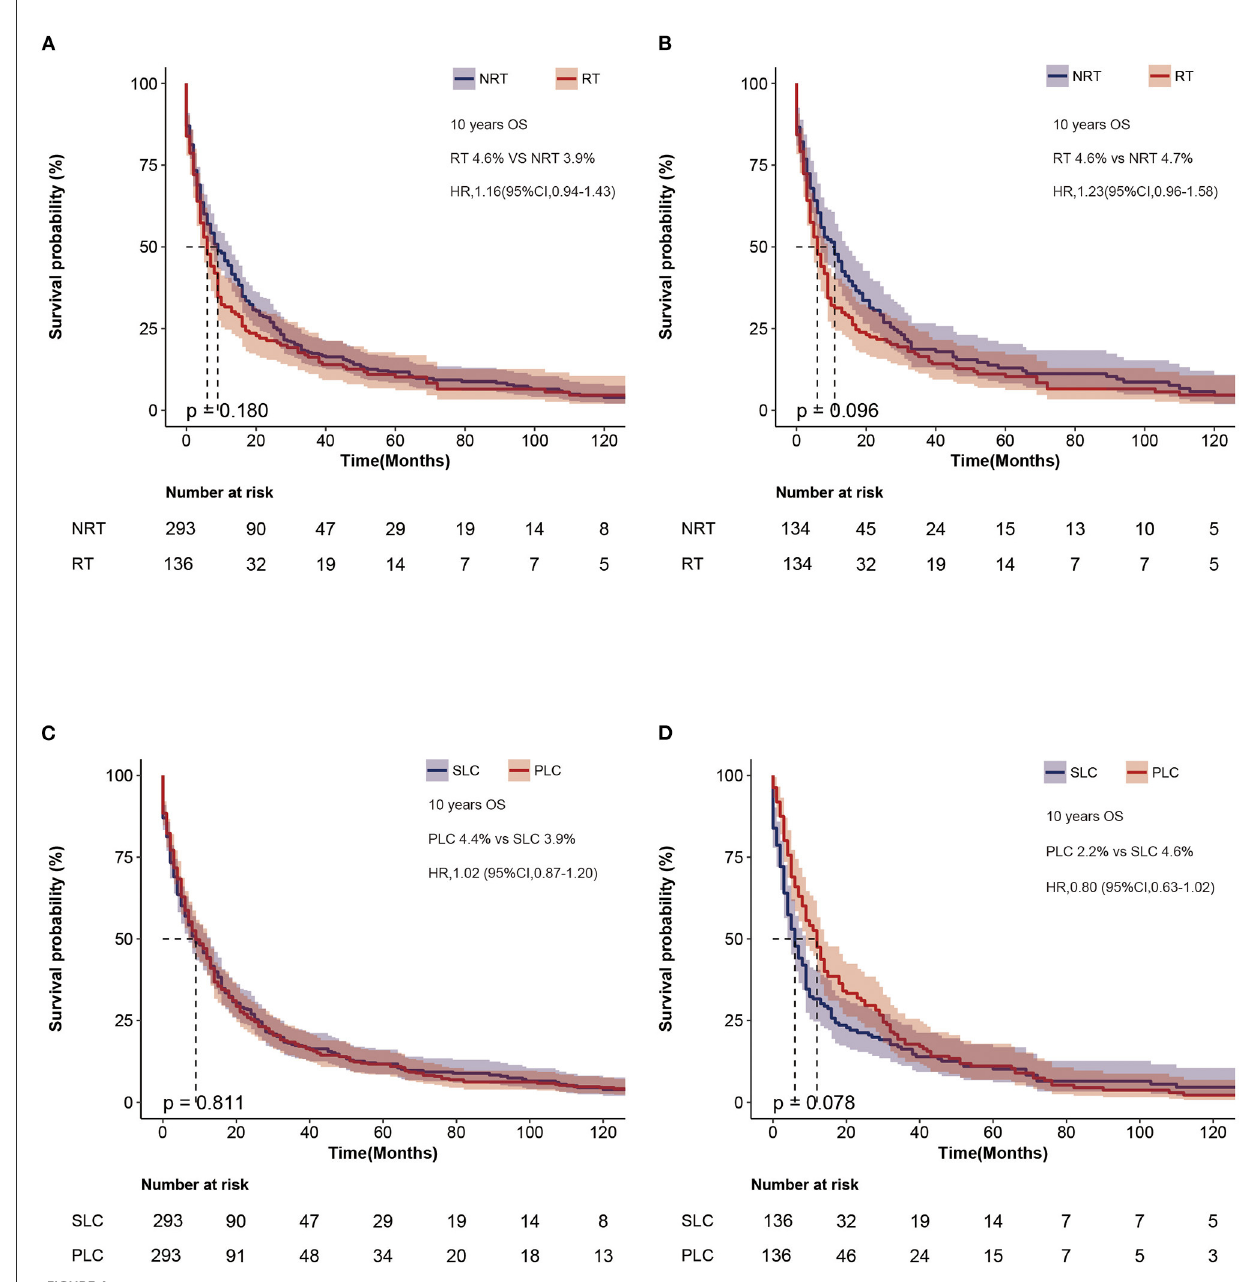
FIGURE4 Survival outcome of patients with SLC. (A) Overall survival after diagnosis of second lung cancer before matching. (B) Overall survival of second lung cancer between RT and NRT groups after matching. (C) Overall survival between PLC and SLC after matching in the NRT group. (D) Overall survival between PLC and SLC after matching in the RT group. SLC, second primary lung